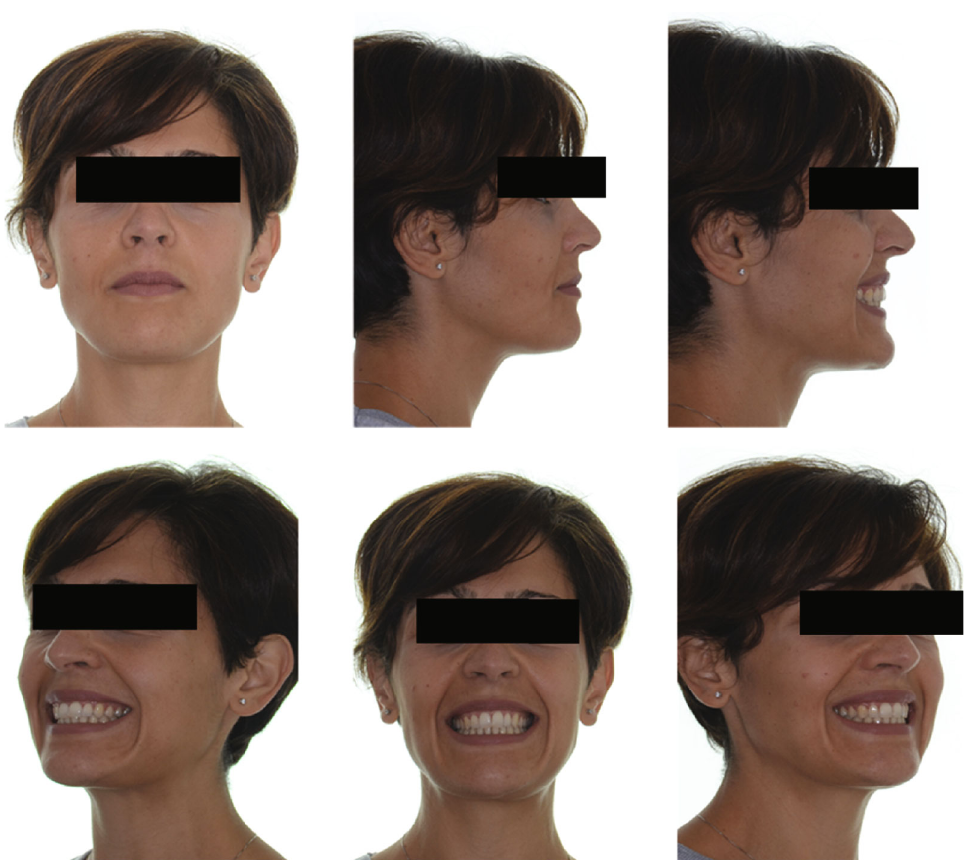
Figure 21: 20-year follow-up extraoral